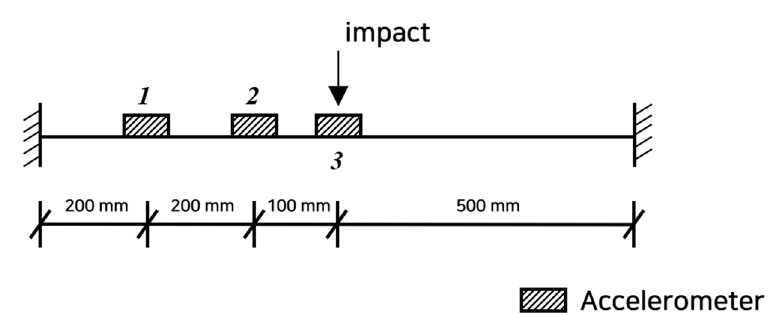
Figure 3. Steel beam of a finite element model with accelerometers and impact hammer.